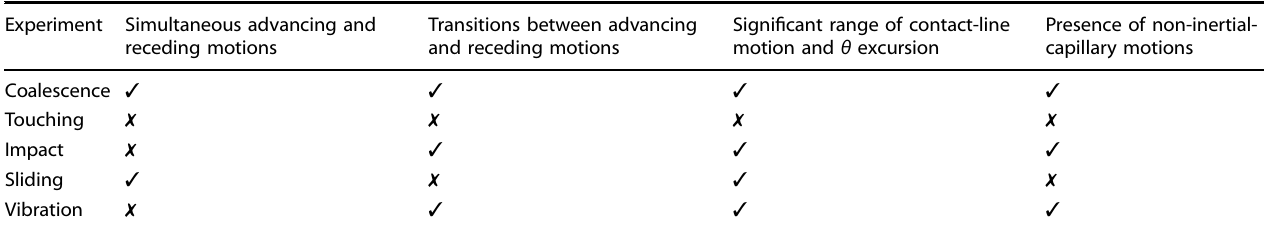
Table 1. Comparison of experiments to test the mobility parameter for inertial-capillary contact-line motions. Experiment Simultaneous advancing and receding motions